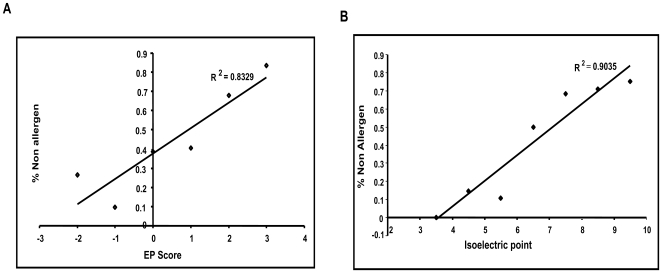
Linear trend analysis shows increasing proportions of non-allergens with increasing EP Score and pI.The proportion of non-allergens is shown as a linear function of surface electrostatic potential (A) and isoelectric point (B)